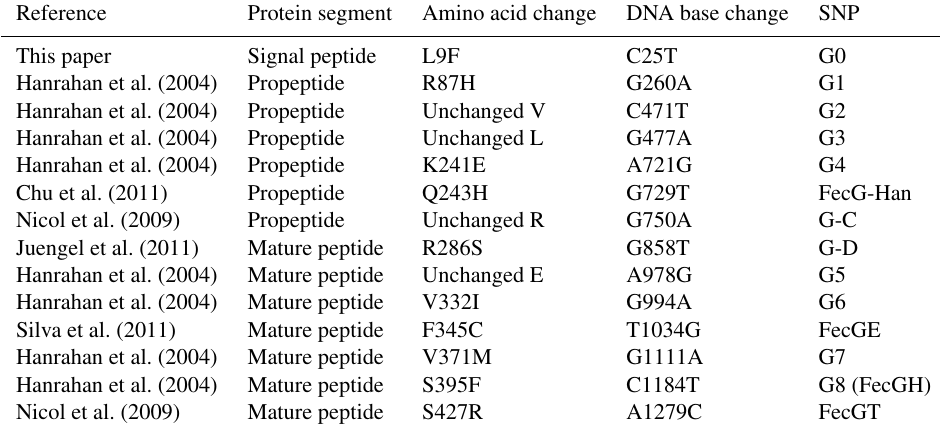
Table 1. A summary of known mutations that have been detected in the GDF9 gene of sheep species around the world. Reference